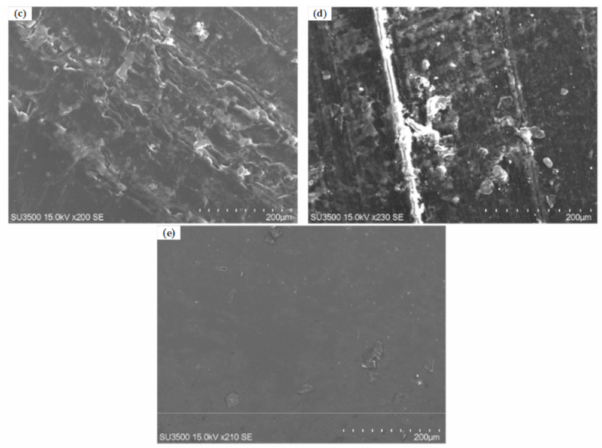
Figure 5. Worn surfaces morphology of CF-PEEK when sliding against 17-4PH and several cermet coatings (100 N, 300 r / min): ( a ) CF-PEEK / 17-4PH; ( b ) CF-PEEK / Cr 3 C 2 -NiCr; ( c ) CF-PEEK / WC-10Co-4Cr; ( d ) CF-PEEK / Cr 2 O 3 and ( e ) CF-PEEK / Al 2 O 3 -13%TiO 2